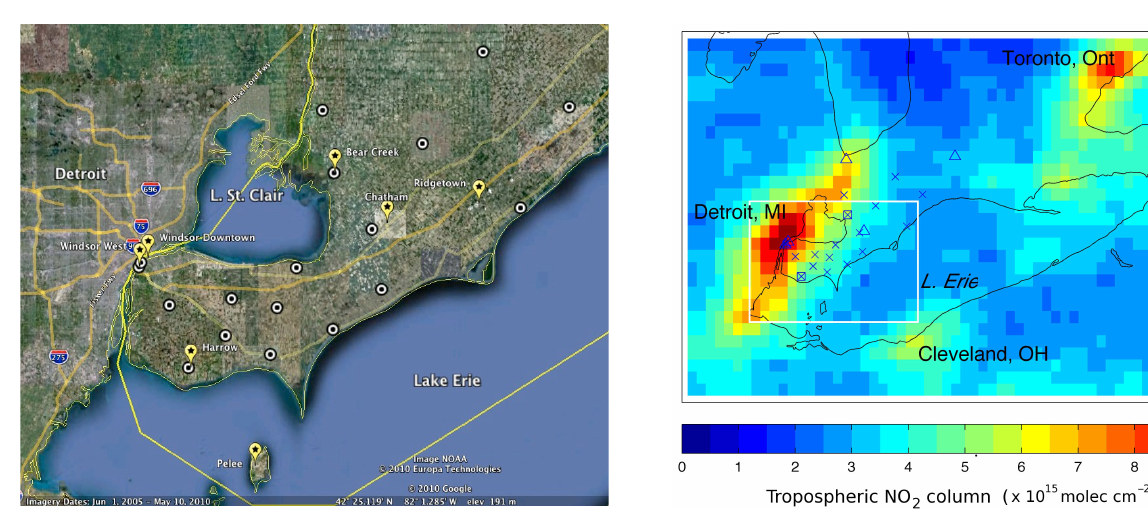
Fig. 2. Campaign average NO 2 column in Southwestern Ontario. BAQS-met passive monitoring sites are marked by Xs, triangles represent permanent MoE molybdenum converted NO x monitoring locations and squares denote locations of EC photolytically con- verted NO x monitors during the campaign. White rectangle outlines area encompassed by Fig.